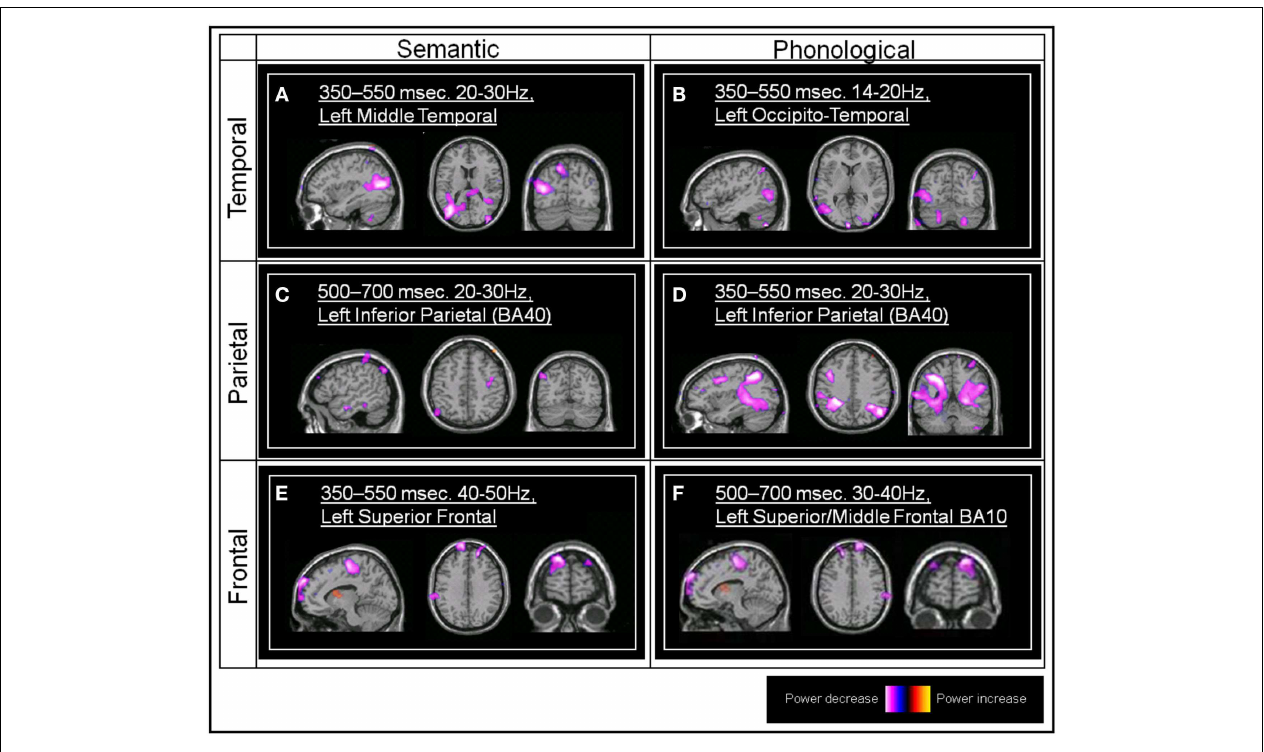
value =− 3.71). (D) The left inferior parietal effect associated with the phonological task (TC: − 36, − 48, 39, pseudo- T value =− 4.36). (E) The left superior frontal effect associated with the semantic task (TC: − 15, 69, 33, pseudo- T value =− 3.94). (F) The left superior/middle frontal (BA10) effect associated with the phonological task (TC: − 39, 39, 30, pseudo- T value =−